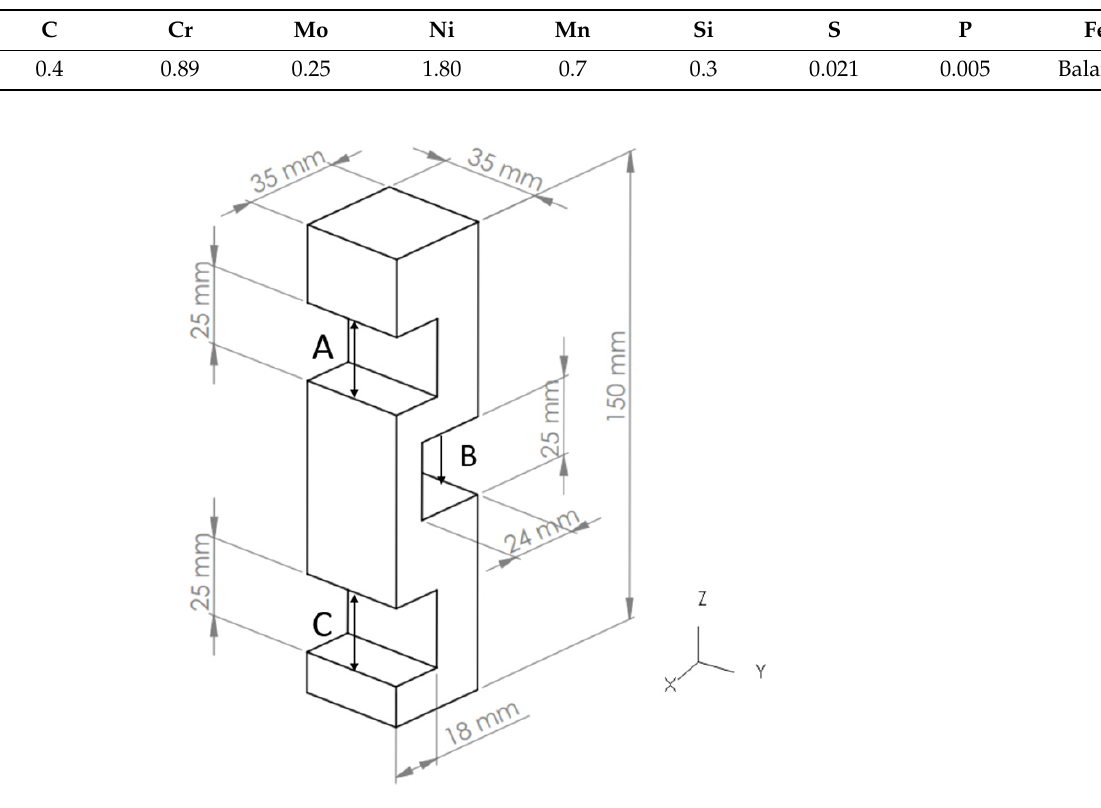
Figure 1. Geometry and dimensions of the part studied.